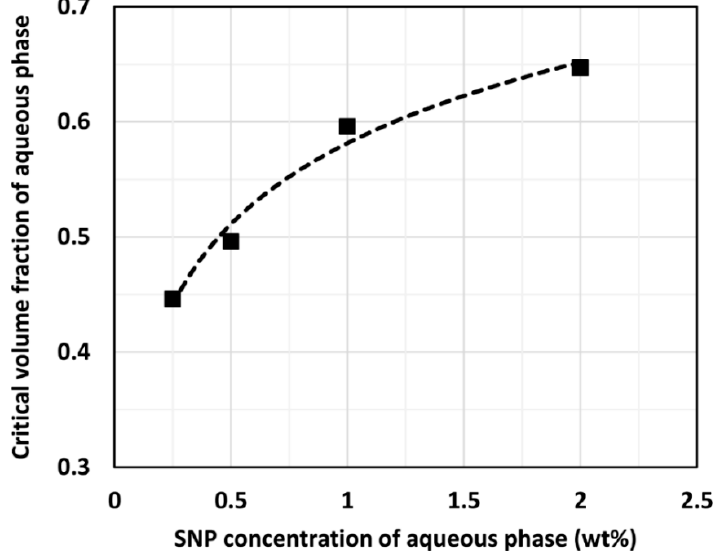
Figure 14. Effect of SNP concentration of aqueous phase on the critical volume fraction of aqueous phase where phase inversion of W/O to O/W emulsion takes place.